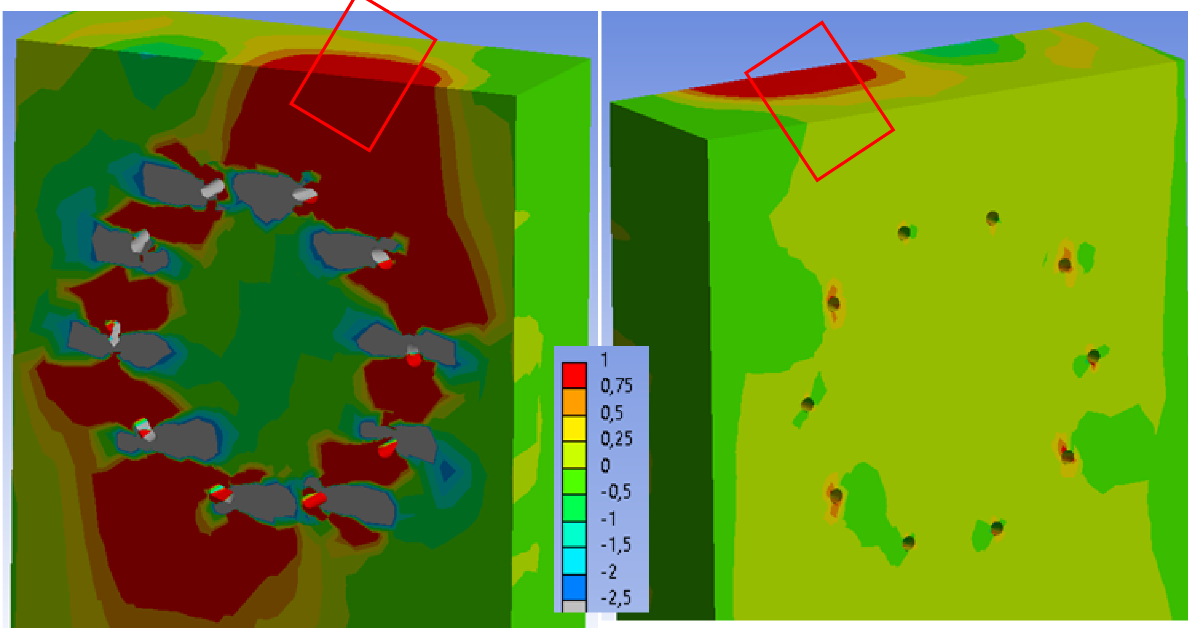
Figure 24. Experiment A: Collapse of the connection during experimental testing (on the ( left )), tensile stress perpendicular to the grain from the numerical model (MPa) (on the ( right )).